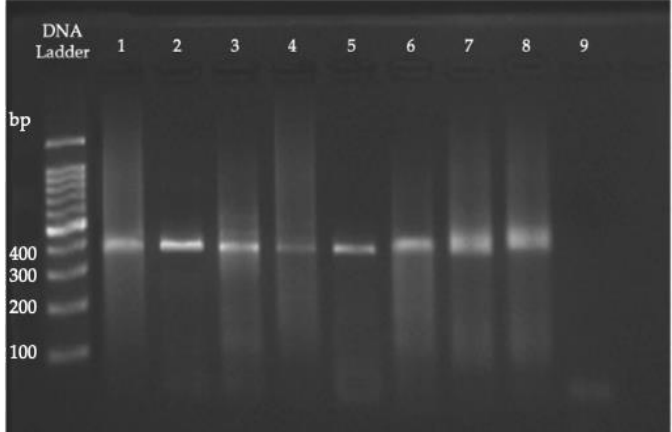
Figure 1. Amplicons of 384 bp in size from the second PCR reaction ( G. duodenalis ). Lane 1 corresponds to control; lanes 2–8 correspond to the pools analyzed; lane 9 corresponds to the negative control.